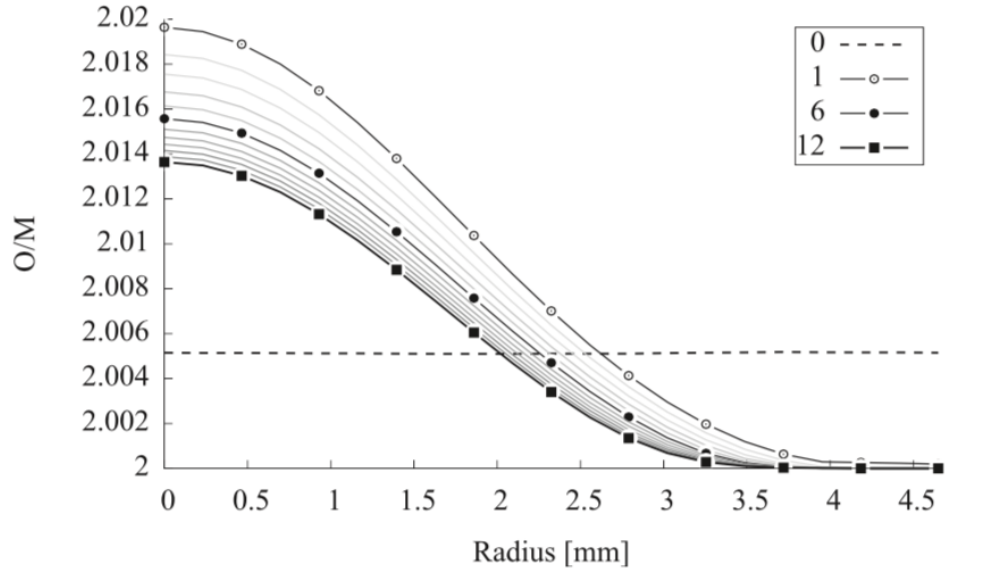
Figure 3. The predicted oxygen-to-metal ratio in the fluorite phase across the radius of a PWR fuel pellet by Simunovic et al. is shown at different time intervals